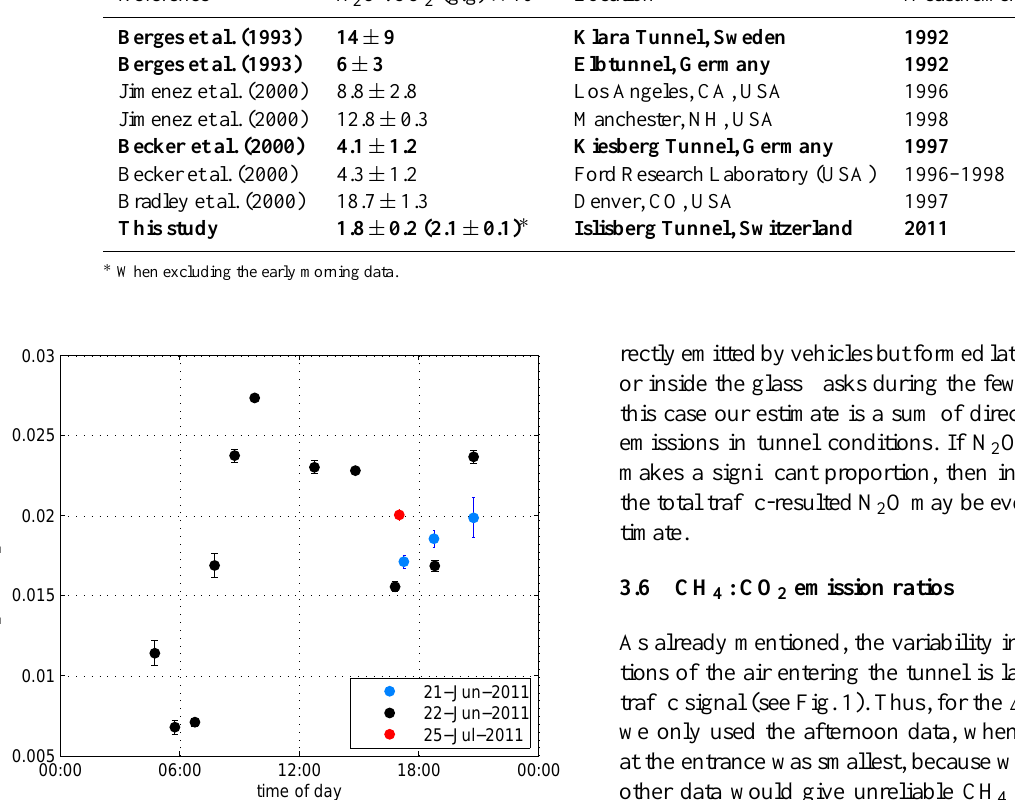
Table 2. Traffic emission N 2 O:CO 2 ratios from various studies. The bold text shows the studies concerning European traffic. Reference